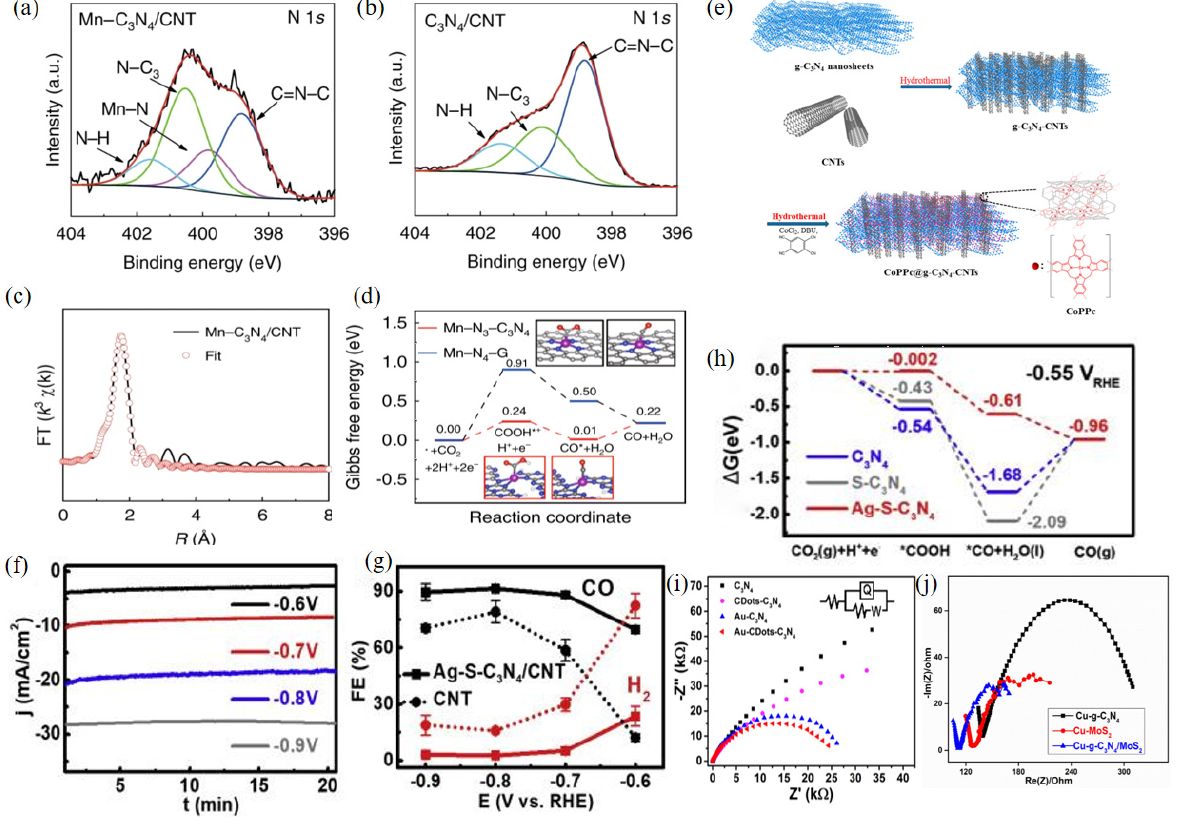
Figure 8. N 1s XPS spectra of Mn-C 3 N 4 /CNT ( a ) and C 3 N 4 /CNT ( b , c ) Mn-C 3 N 4 /EXAFS CNT fitting curve in R space. ( d ) The calculated Gibbs free energy diagrams of the electrocatalytic reduction of CO 2 by Mn-N 3 -C 3 N 4 and Mn-N 4 -G; reprinted with permission from ref [100], Copyright 2020, the